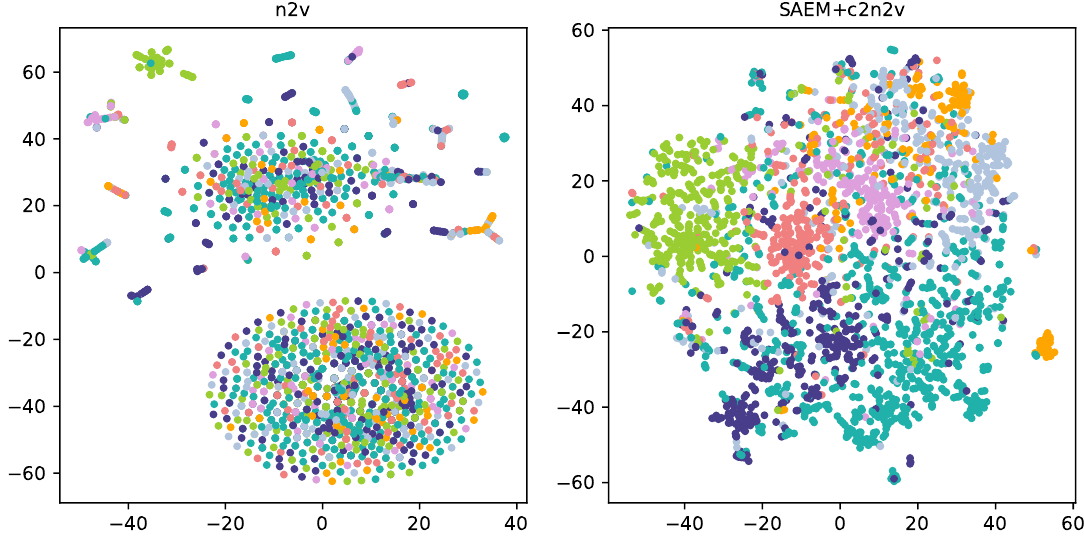
Figure 5. t-SNE visualization between n2v and SAEM+c2n2v in Cora data. Colors indicate labels of nodes.